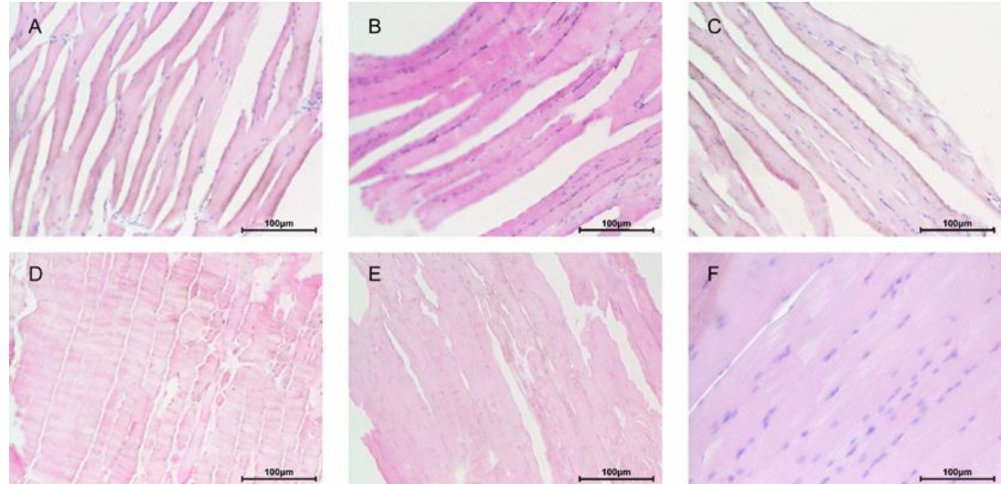
Figure 2. Muscle morphology was evaluated by H&E staining. ( A ) CTRL group; ( B ) Taurine group; ( C ) HPM-H group; ( D ) HPM-L group; ( E ) HPS-H group; ( F ) HPS-L group. Scale bar: 100 µ